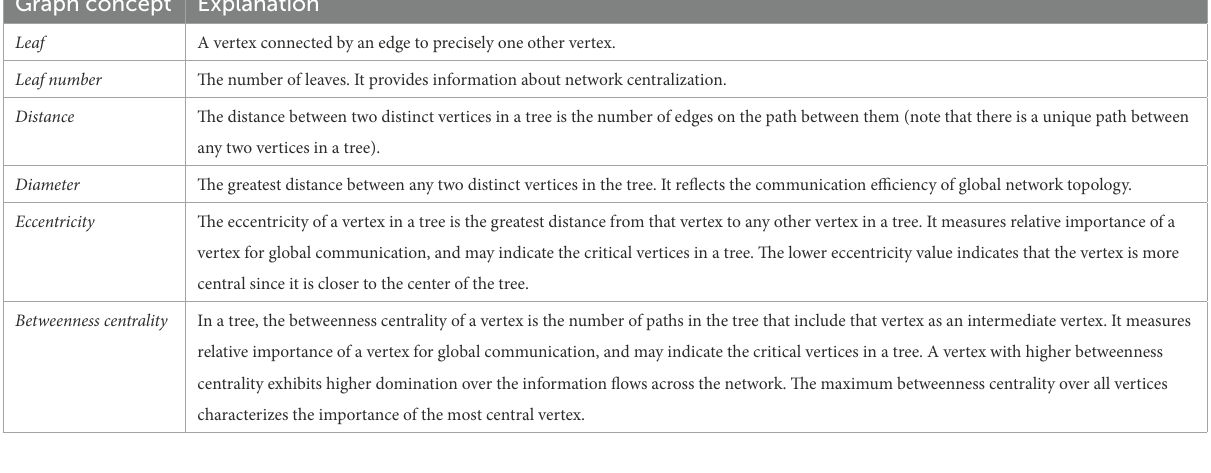
TABLE 3 Basic concepts and measures on a